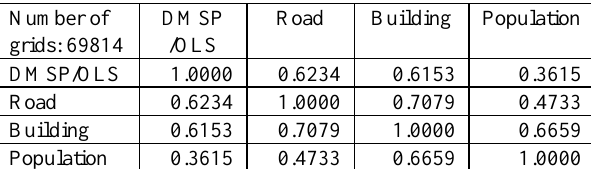
Table 3. Correlation table in whole area of Tohoku region